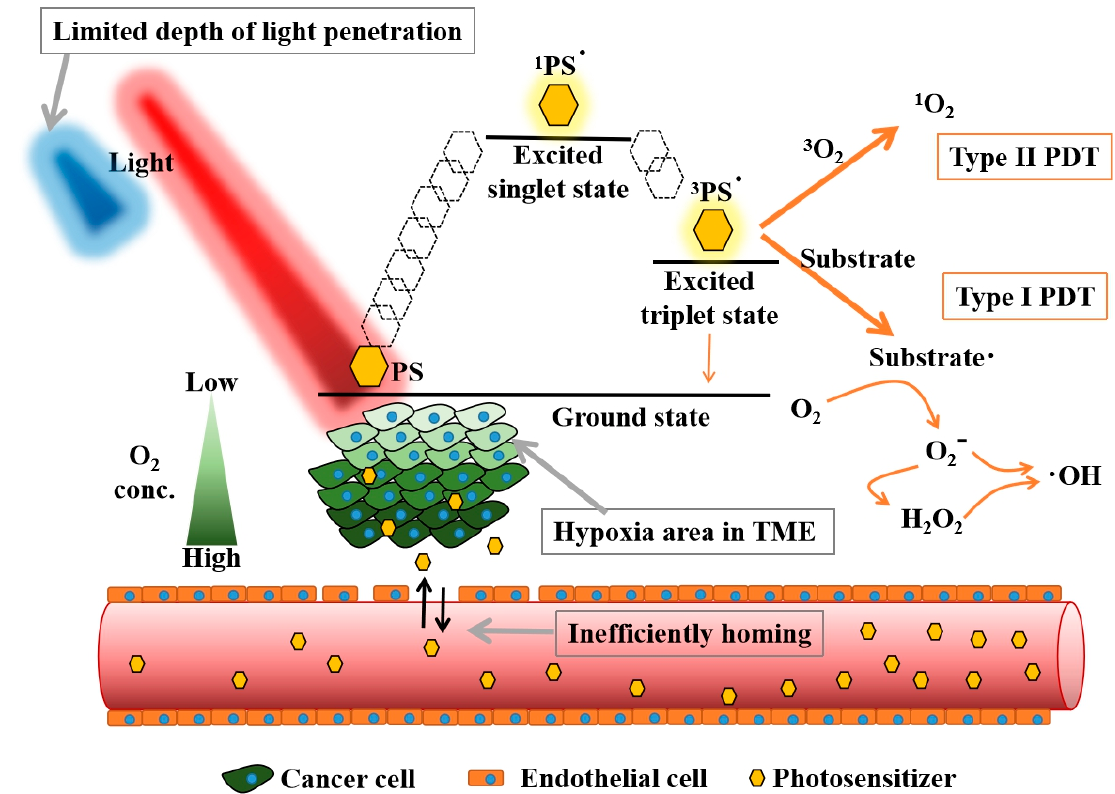
Figure 1. The principle of photodynamic reaction and its basic limitations applied in deep-seated tumor treatment. PS: Photosensi- tizer, TME: Tumor microenvironment.